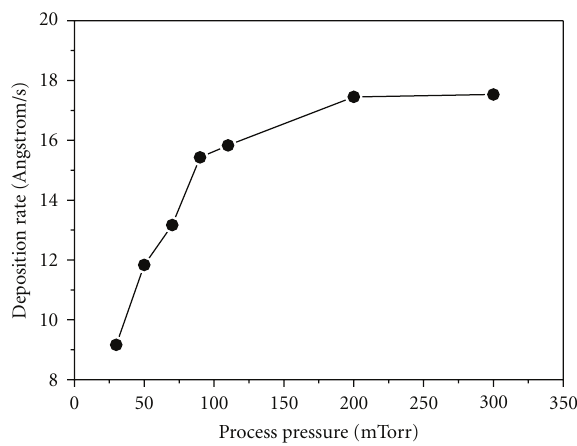
Figure 2: Variation of deposition rate as a function of process pressure for Si:H films deposited by hot wire method.